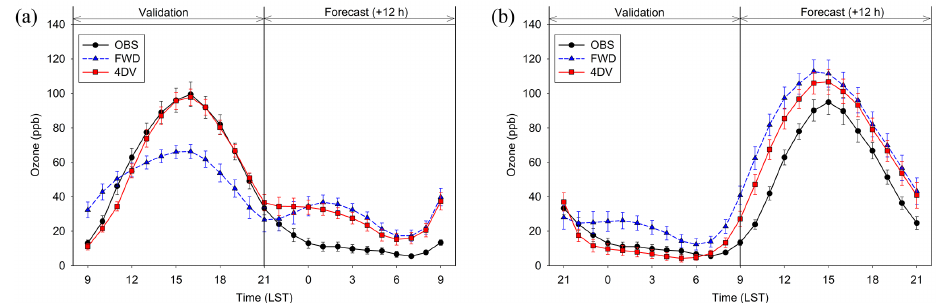
Figure 18. Time variations of observed and forecast ozone concentration after (a) daytime and (b) nighttime assimilation. All 120 sites data are averaged and its 3 standard errors also displayed with vertical bars. Triangle over blue dashed line, circle over red solid line, and dot over black solid line stand for forward run (FWD), 4D-Var run (4DV), and observation (OBS) results,